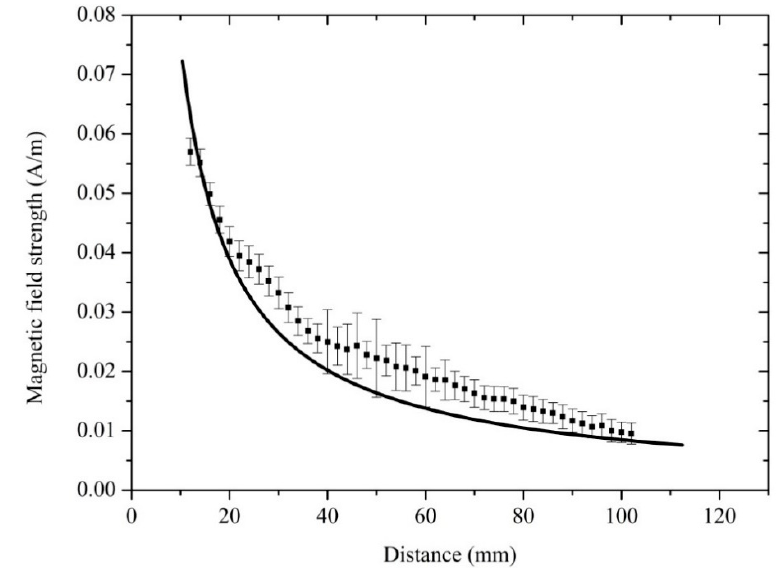
Figure 6. The distribution of microwave magnetic field strength along the direction of o-x (showed in Figure 5c). The square solid spot represents the measured magnetic field strength, and the solid line represents the simulated field strength. The simulated data were extracted from the results showed in Figure 5b. The magnetic field strengths were measured by changing the position of the Cs glass cell along the direction of o-x. The measurement distance was changed from 12 to 102 mm and ω m /2 π = 500 Hz. The variation trend of the measured results was roughly identical to the simulated results. The measured results are a little more than the simulated results at every measurement points. It is because the glass cell had a resonance effect on the microwave magnetic field when the Cs glass cell was inserted. The error bars on square solid spot represents the measurement uncertainty.